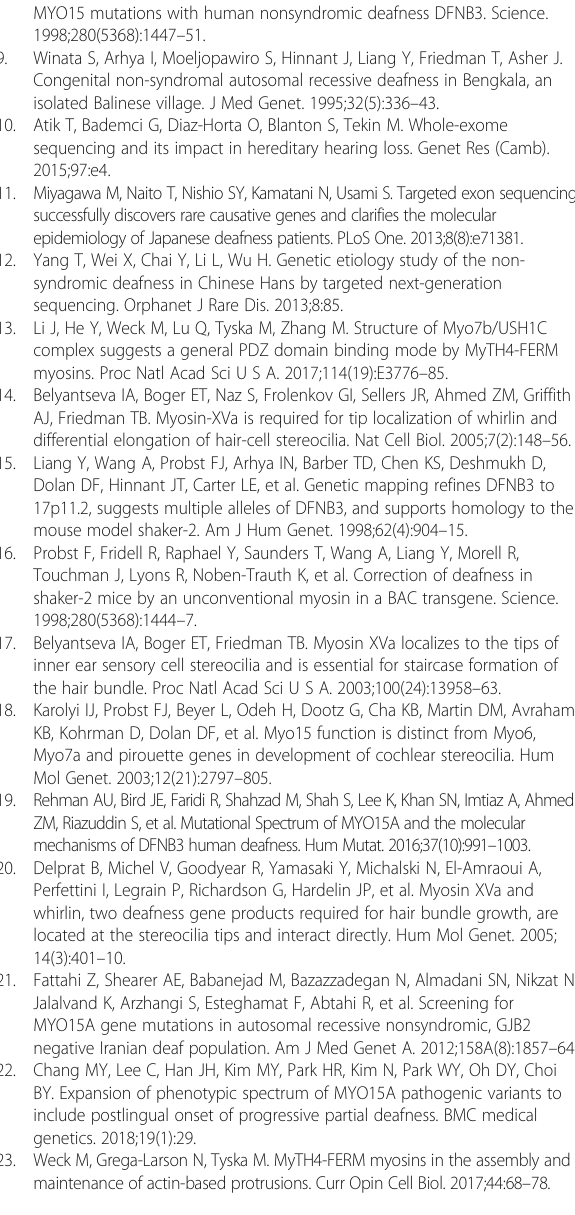
Additional file 2: Table S2. Overview of target region capture sequencing results of the proband affected by ARNSHL. (DOCX 15